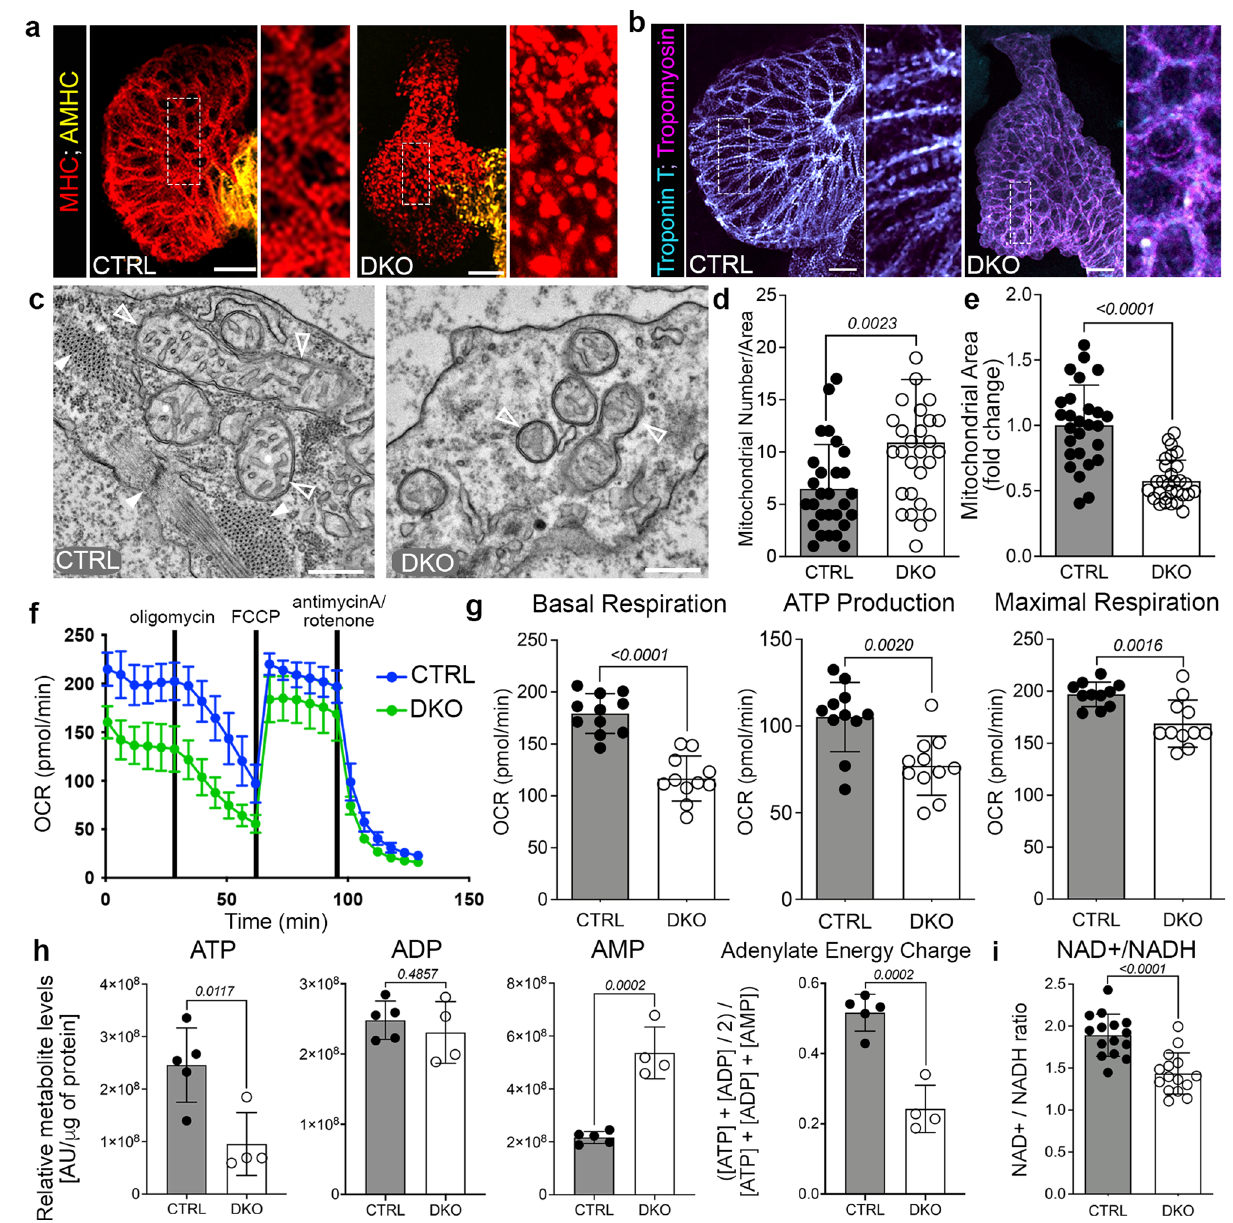
Fig. 5 | Rbfox proteins mediate sarcomere assembly and mitochondrial respiration. a , b Merged confocal projections of 48hpf CTRL or DKO hearts immunostained for MHC and AMHC ( a ), and Troponin T and Tropomyosin ( b ). Magni fi edviewsofboxedregionsareshown. c Transmissionelectronmicrographs (TEMs) of ventricular cardiomyocytes in 48hpf CTRL or DKO. White arrowheads highlight sarcomere bundles and a Z-line in CTRL. Open arrowheads highlight mitochondria. d , e Dot plots depicting mitochondrial numbers per area and fold change in mitochondrial area. f Graph of seahorse mito stress test to measure oxygenconsumptionrates(OCR)of48hpfCTRLorDKOembryos.Drugadditionis indicated. g Dotplotsfromrawdatain f . h Dotplotsofmetabolomicsdatain24hpf CTRLorDKOembryos. i DotplotshowingNAD+/NADHratioat48hpfbyGloAssay. Sample sizes and statistics: ( a , b ) Little to no variation in expression was observed.